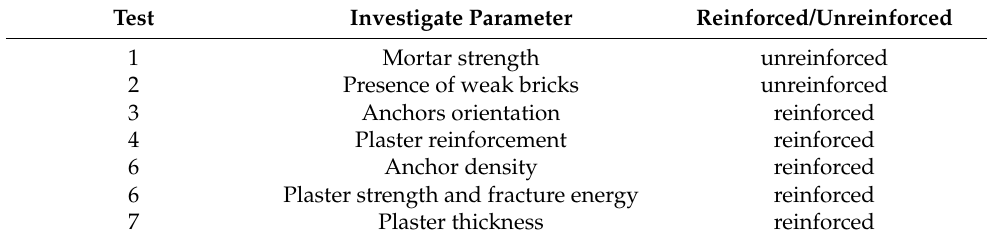
Table 3. Summary of the performed simulations.